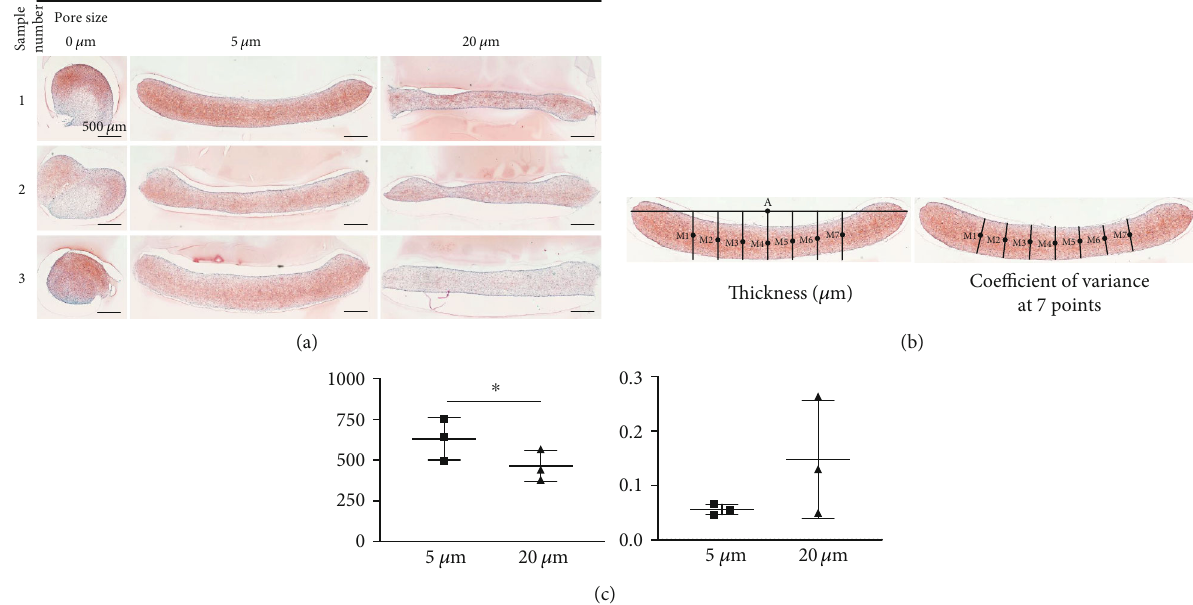
Figure 5: Histological images and thickness of cartilage derived from synovial MSCs plated on PLA fi lms. (a) Histological images. MSCs ( 5 : 0 × 10 5 in 500 μ L medium) were plated, cultured in chondrogenic induction medium for 14 days, and stained with safranin O. The results of three di ff erent samples are shown. (b) Method for measuring the cartilage thickness. A single line was drawn along the long axis of the cartilage, the midpoint of both ends of the cartilage was determined on this line (point A), and seven perpendicular lines were drawn every 500 μ m on both sides from “ point A. ” The midpoints of both ends of the cartilage were determined on each vertical line (M1-M7), and the minimum width through these points was determined. (c) Average thickness of the cartilage and the coe ffi cient of variance for cartilage thickness at 7 points. Means and standard deviations are shown ( n = 3 ). ∗ P < 0 : 05 . P values were determined by a paired Student ’ s t